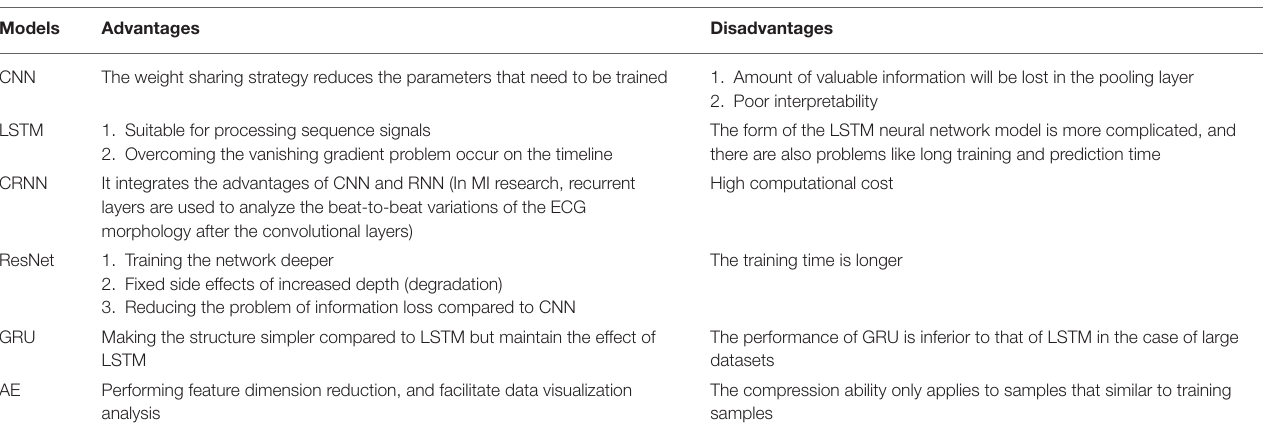
TABLE 10 | Advantages and disadvantages of the six different deep learning (DL)